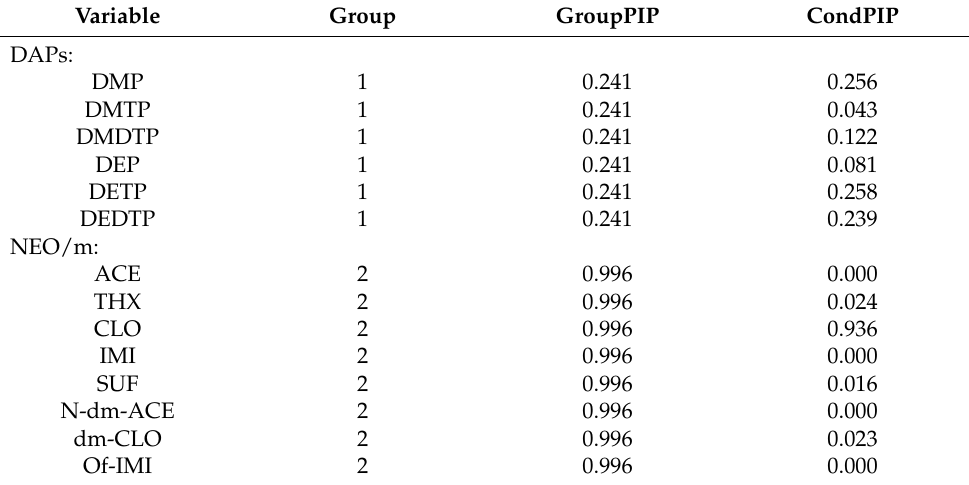
Table 3. Posterior inclusion probabilities (PIPs) for group inclusion and conditional inclusion in mean corpuscular haemoglobin concentration (MCHC) models using the Bayesian kernel machine regression (BKMR) model.